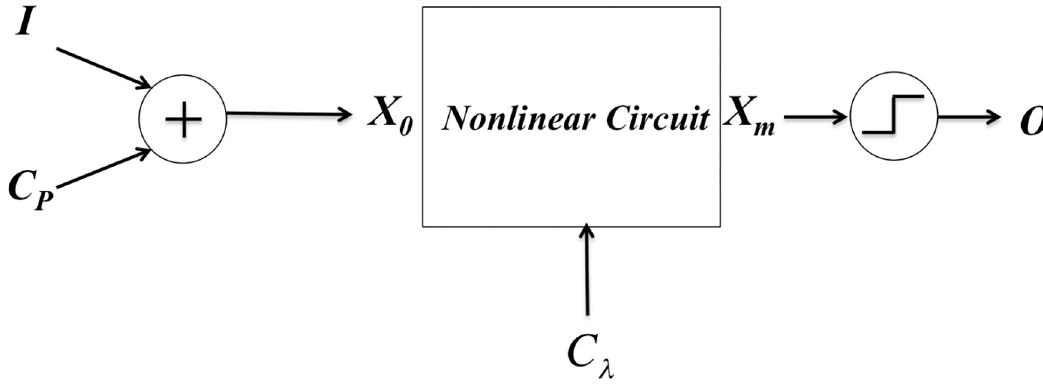
Fig 1. Block diagram for a NLDBM logic